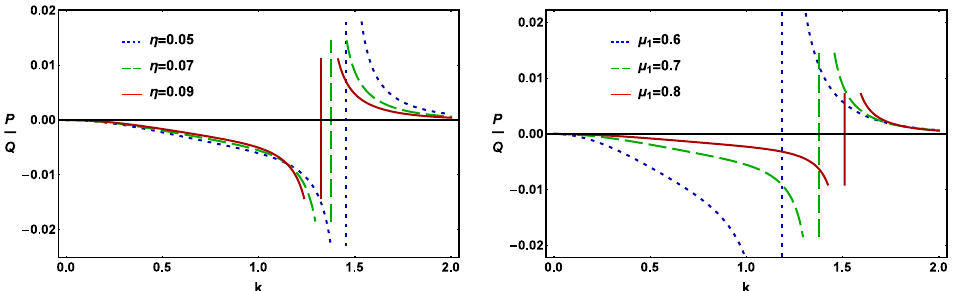
Figure 2. Plot of P / Q vs. k for the change of η (left panel) and µ 1 (right panel) when ρ = 1.2, (cid:36) = 1.5, κ = 2, and µ 2 =